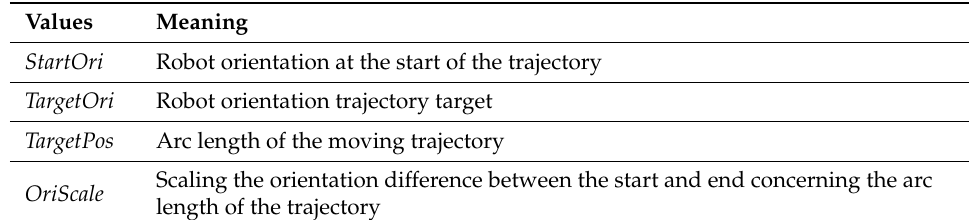
Table 1. Important parameters of